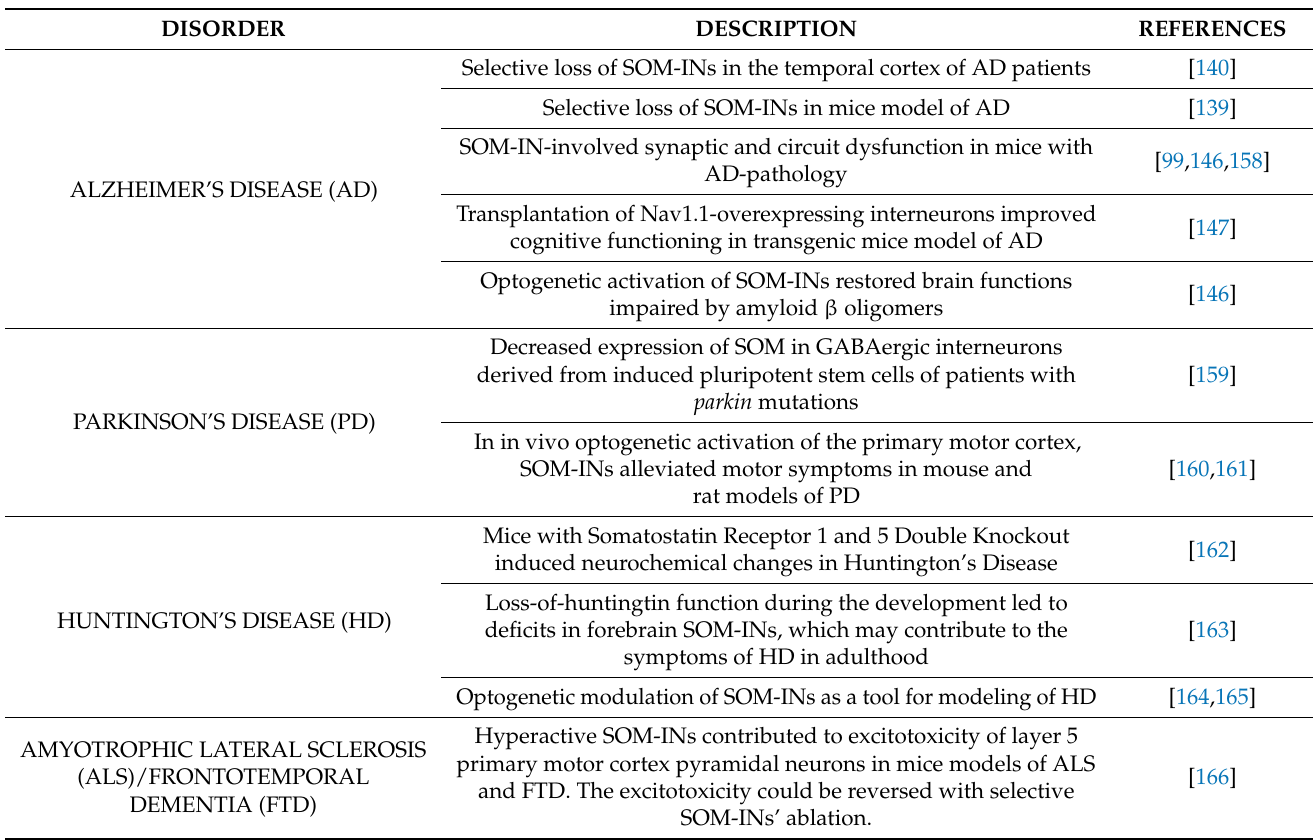
Table 1. Somatostatin and somatostatin-expressing interneurons in major neurodegenerative disorders—the